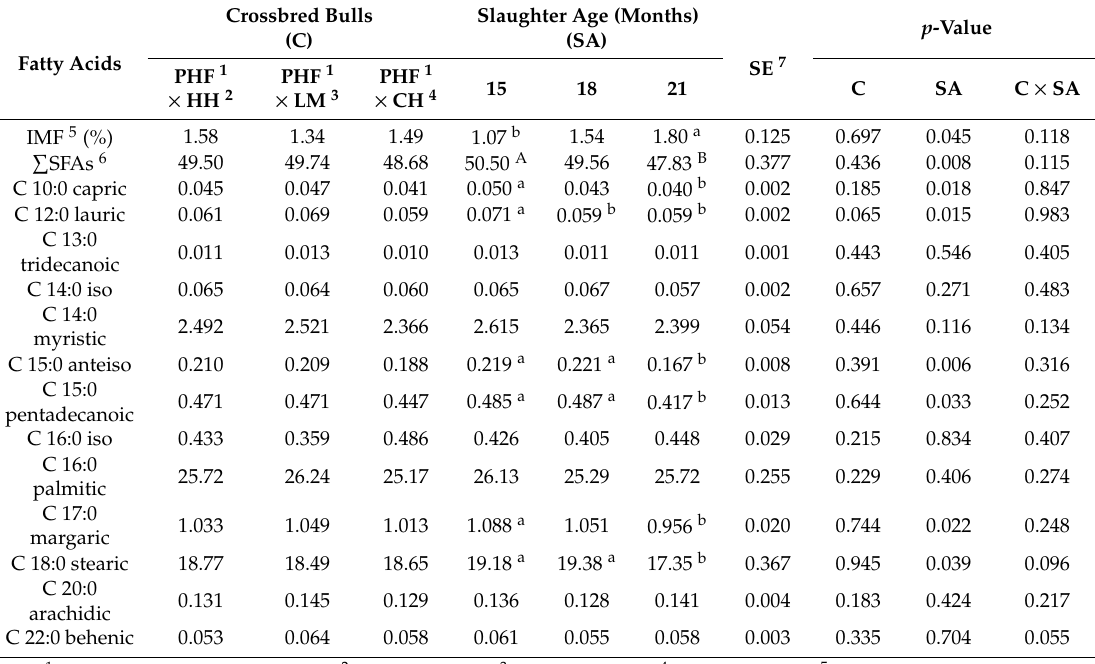
Table 5. Content of saturated fatty acids (%) in the longissimus thoracis muscle of crossbred bulls.